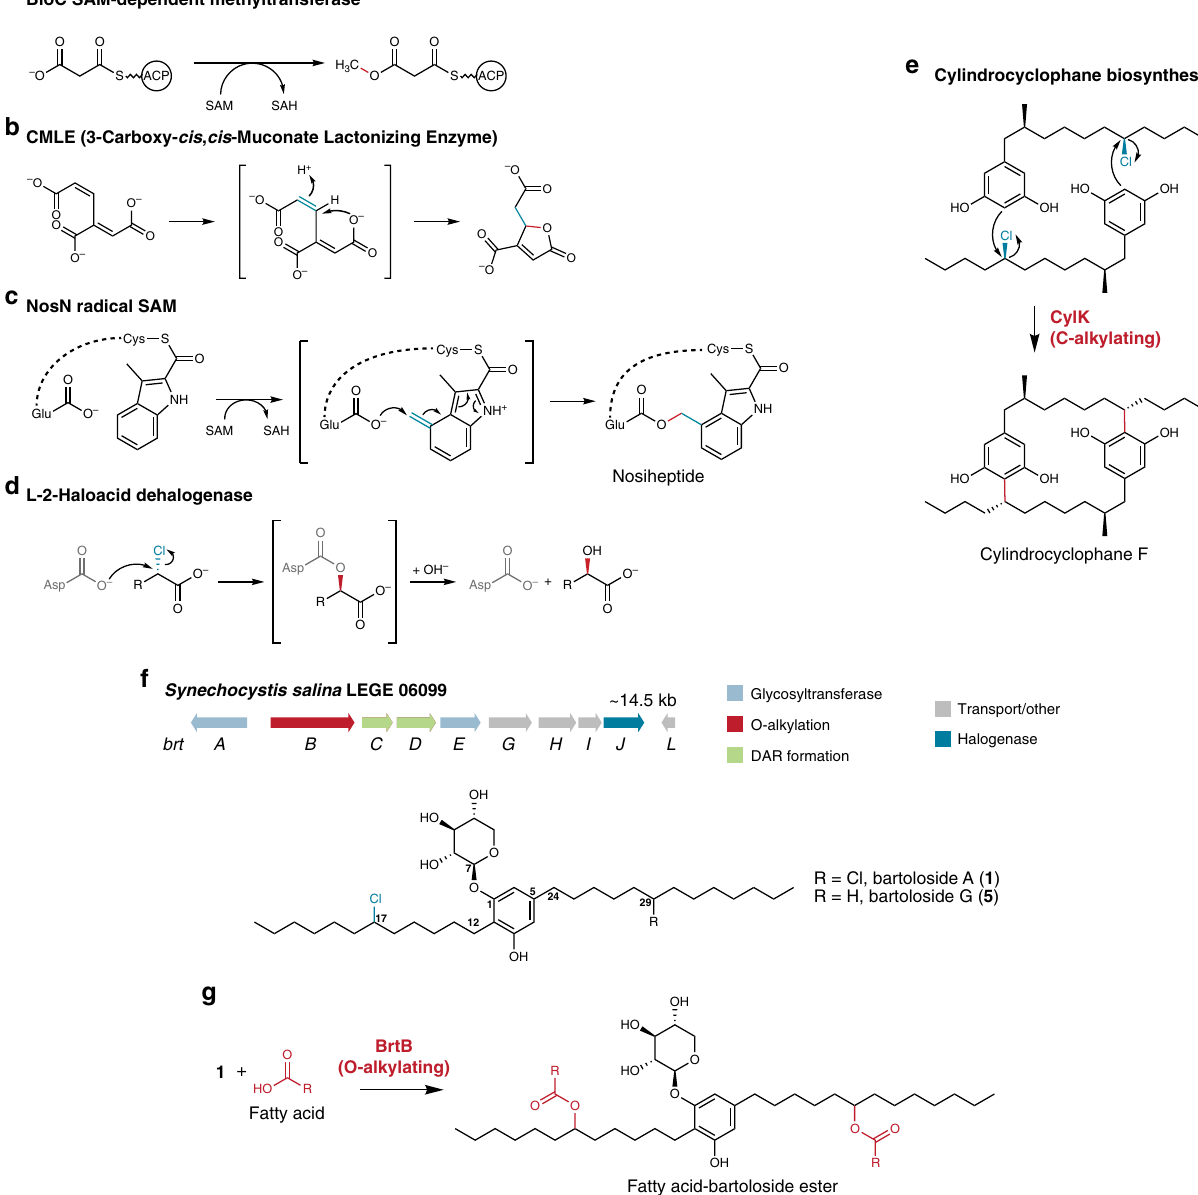
Fig. 1 Selected O- and C-alkylating enzymes. a BioC is a SAM-dependent methyltransferase acting in biotin biosynthesis. b CMLE is an eukaryotic beta-propeller enzyme catalyzing an intramolecular addition of a carboxylate to a double bond. c NosN, a radical SAM enzyme, generates an exomethylene intermediate that drives intramolecular ester bond formation. d Dehalogenation of alkyl halides catalyzed by L -2-haloacid dehalogenases involves the transient formation of an ester species resulting from the nucleophilic attack of a side chain carboxylate onto the chlorinated carbon. e In cylindrocyclophane biosynthesis, each alkylresorcinol moiety is alkylated at the C-2 position by CylK. f The brt gene cluster from Synechocystis salina LEGE 06099 encodes the production of a number of bartolosides, the most abundant of which are bartolosides 1 and 5 (depicted). g BrtB catalyzes O – C bond formation between non-activated fatty acids and